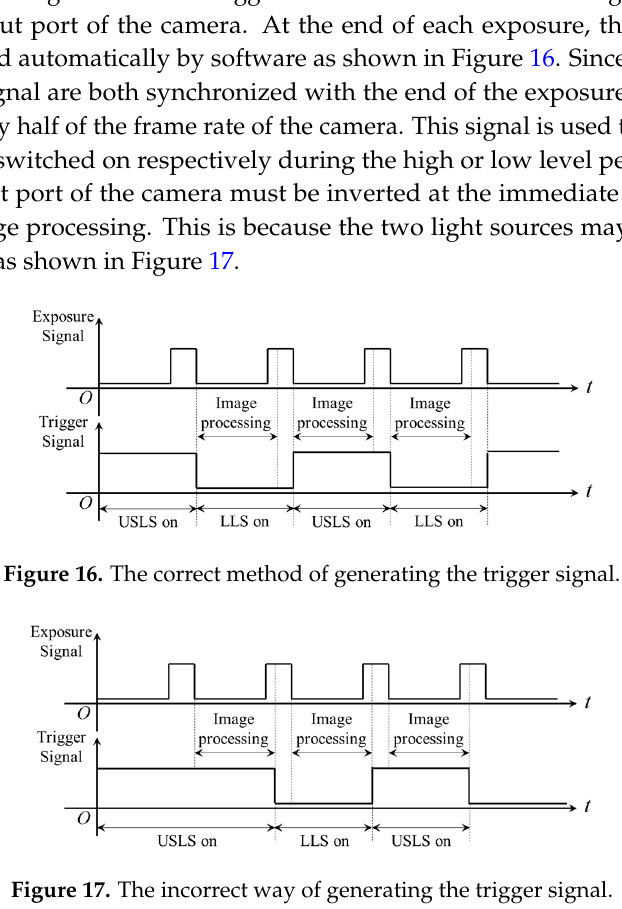
Figure 17. The incorrect way of generating the trigger signal.